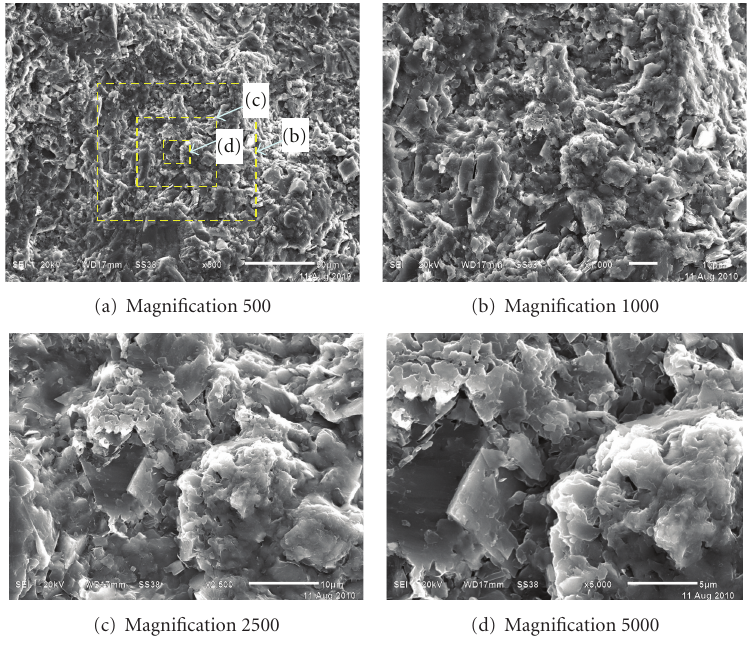
Figure 4: SEM images of grey sandstone with di ff erent magnification.